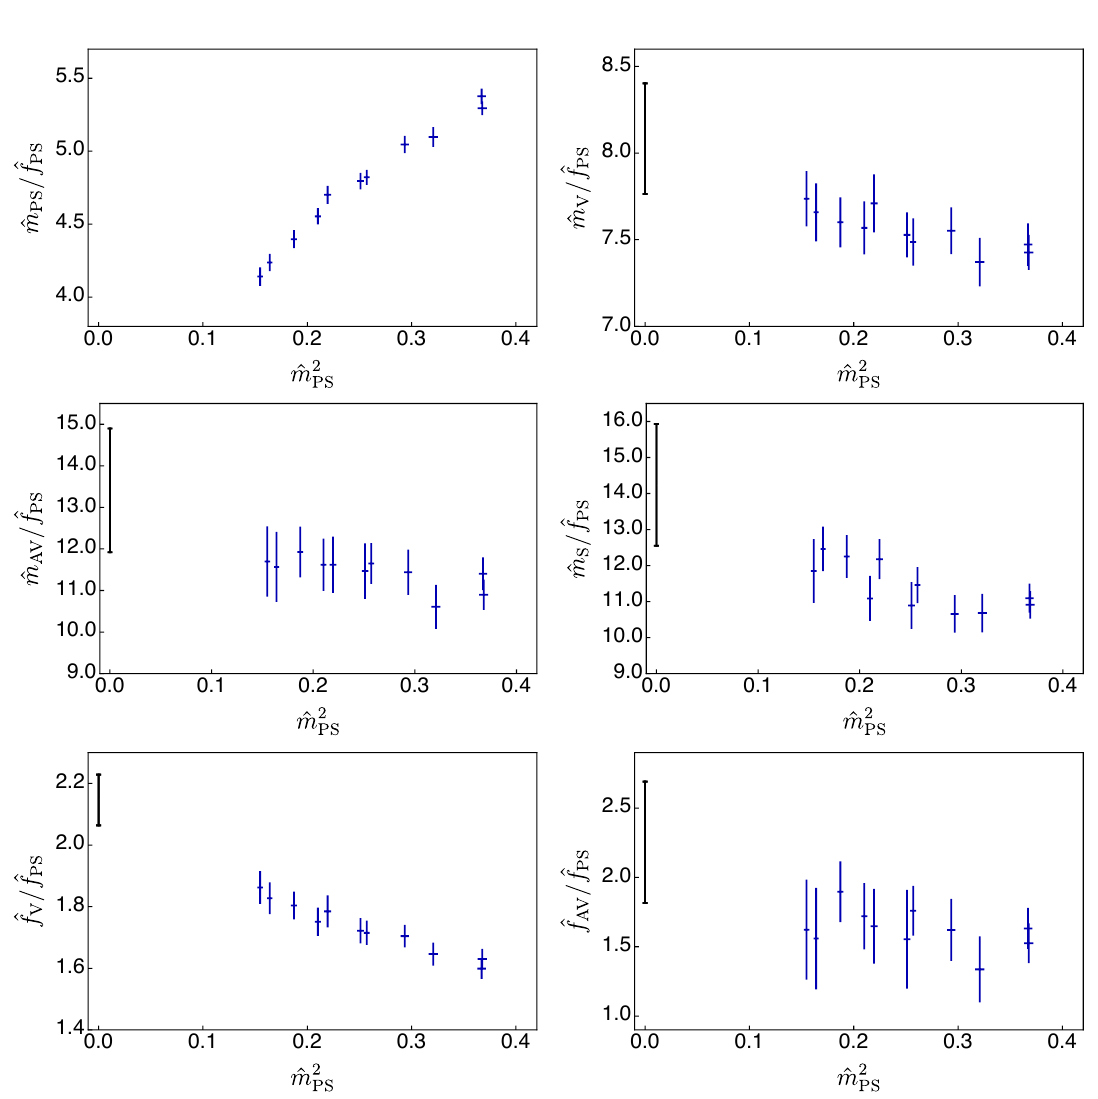
Figure 16. Ratios of masses and decay constants, in the continuum limit, expressed in units of the decay constant of the PS meson (as in table 11), shown in blue. We also show the extrapolation to the continuum and massless limit in black, except for ^ m PS , which vanishes in the limit of massless